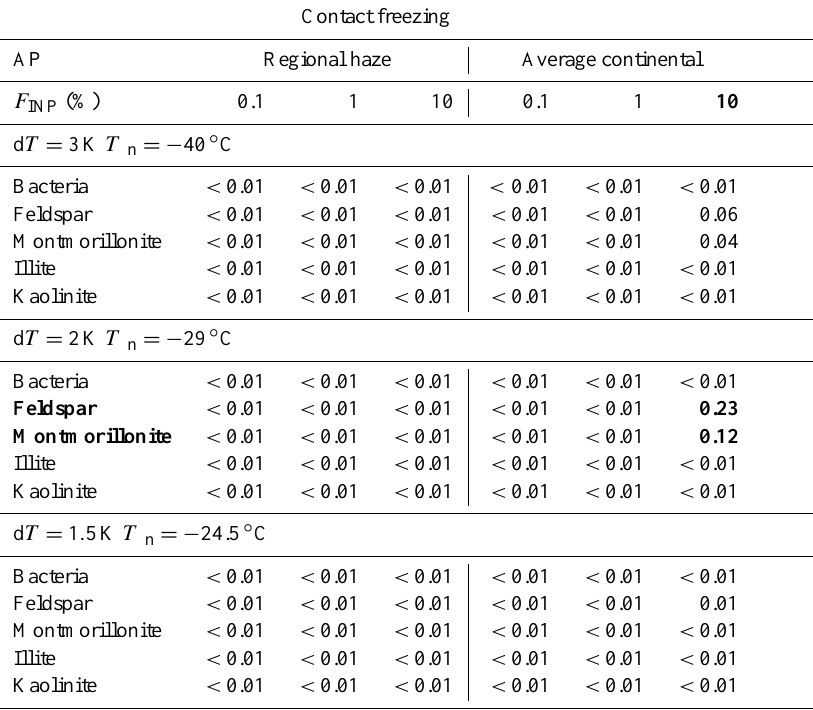
Table 6. Ice water fractions from sensitivity studies with contact freezing. Liquid clouds: IWF < 0.1, mixed-phase clouds: 0.1 ≤ IWF ≤ 0.9, and ice clouds: IWF > 0.9. Cases referring to mixed-phase clouds and ice clouds are written in